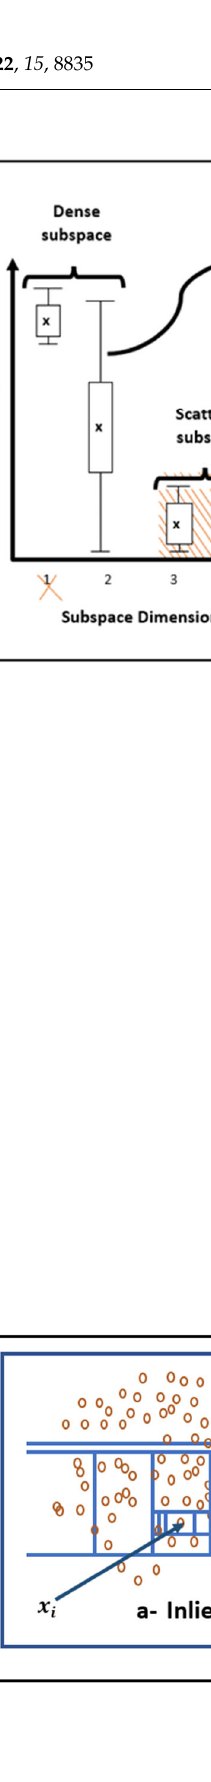
Figure 14. The actual flow rate of ( a ) well_12, ( b ) well_29, ( c ) well_40. The noise was removed by 12 OD algorithms. It was assumed that 20% of the data are outliers, and each algorithm should tell which data should be removed according to its base of detecting the outliers. After that, 8 DCA models were applied before and after removing the outliers, then the results were compared. Figure 15 illustrates the method ‐ ology followed in this research.